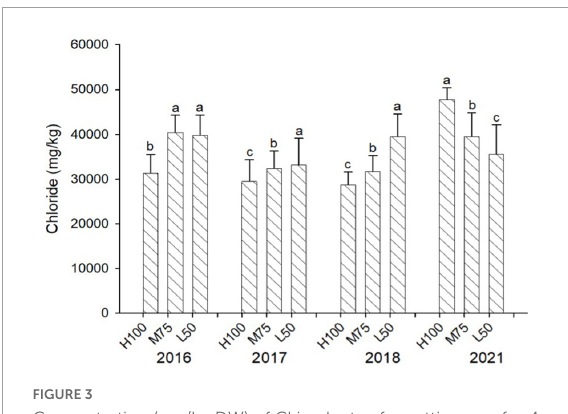
FIGURE5 Concentration (mg/kg DW) of B in plants of agretti grown for 4 years on saline, B- and Se-laden soil and irrigated at different rates (Et o %) with either low-saline water (2016 and 2017) or saline water (2018 and 2021). Statistical difference was performed to analyze the effect of irrigation levels within each planting year (H100 = high 100% Et o , M75 = medium 75% Et o , and L50 = low 50% Et o ) as described in Table 3 . Values represent average ( n = 12 for 100% Et o , n = 9 for 75% and 50% Et o for planting in 2016; n = 19 for 100% Et o , n = 17 for 75% for planting in 2017; n = 18 for planting in 2018, n = 4 for planting in 2021, direct seeding) and error bars represent standard deviation. Different letters indicate that values differed significantly ( P ≤ 0.05), ns = not